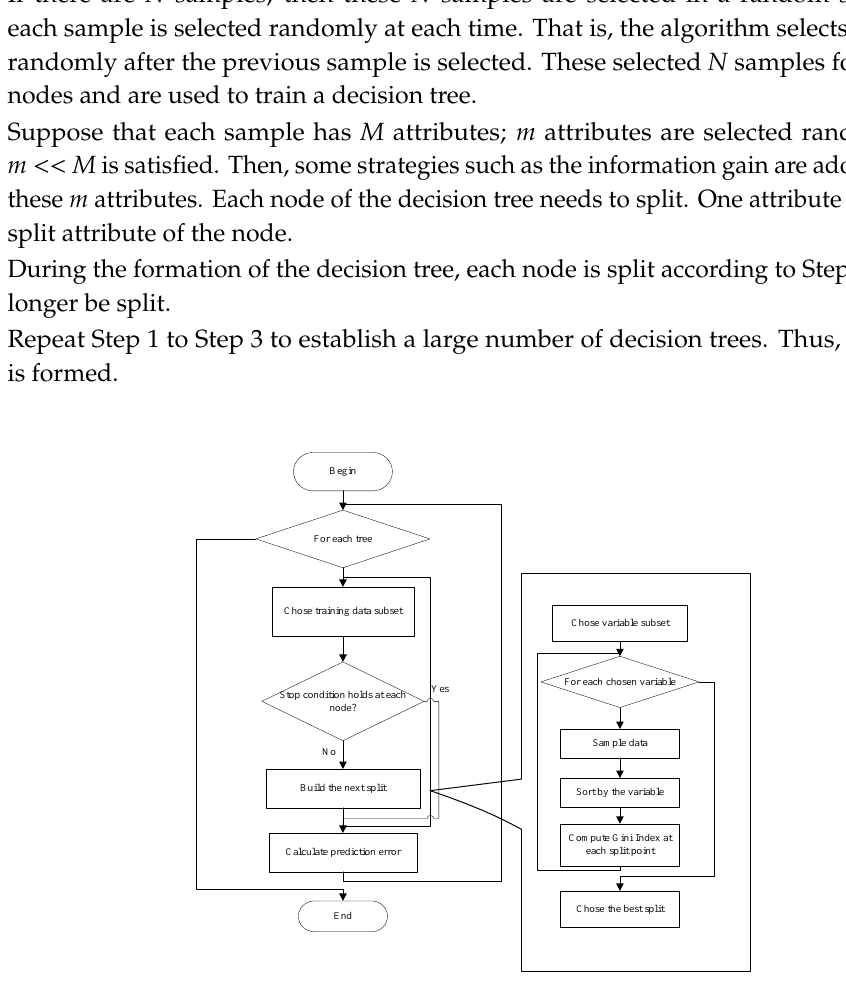
Figure 1. Flowchart showing the procedures of the random forest.